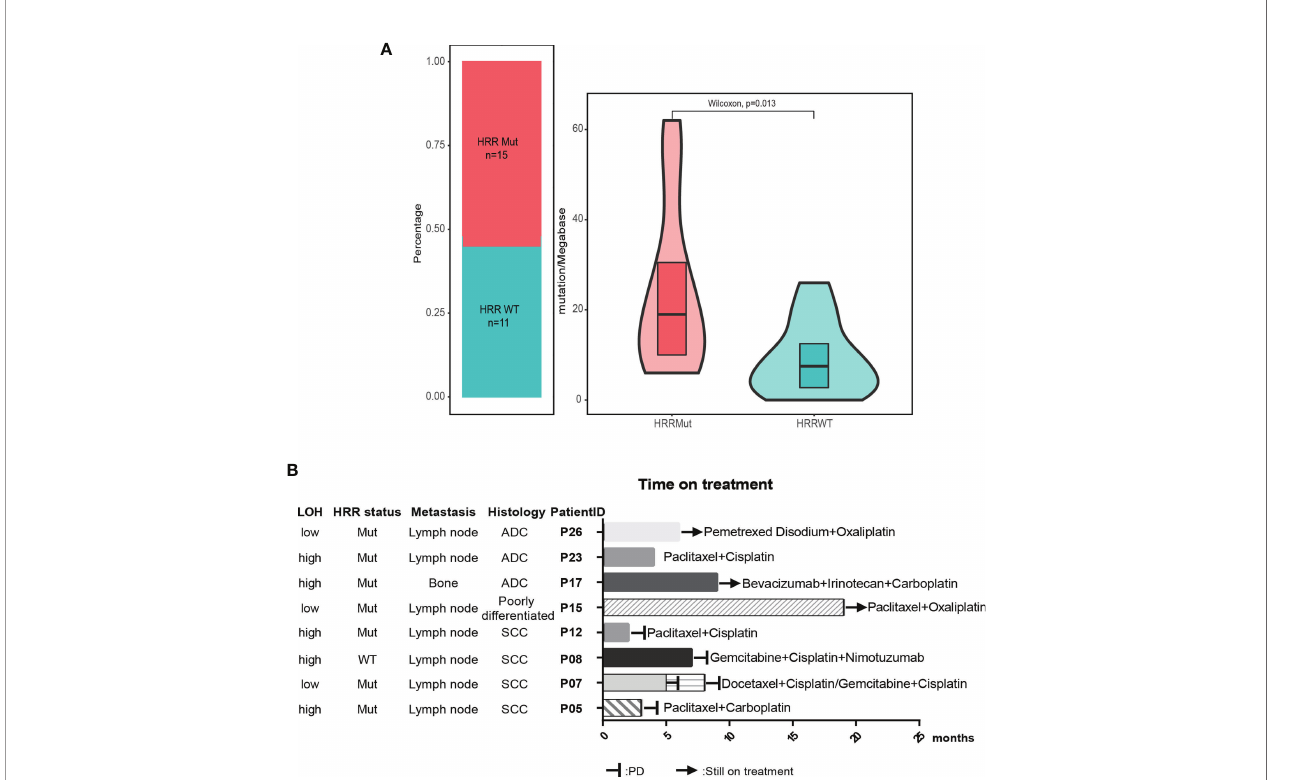
FIGURE 3 | HRR pathway alteration status in patients with unknown primary tumor. (A) Patients with mutated HRR had a higher TMB compared with patients with wild-type HRR. HRR, homologous recombination repair; WT, wild type; Mut, mutated. (B) Available treatment history of patients with unknown primary tumor. Swimmer ’ s plot of time on treatment for eight patients treated with different combination chemotherapy. Patients 5, 7, 8, and 12 had documented PD. Patients 15, 17, and 26 were still on treatment. The information of drug response in patient 23 was unknown. ADC, adenocarcinoma; SCC, squamous cell